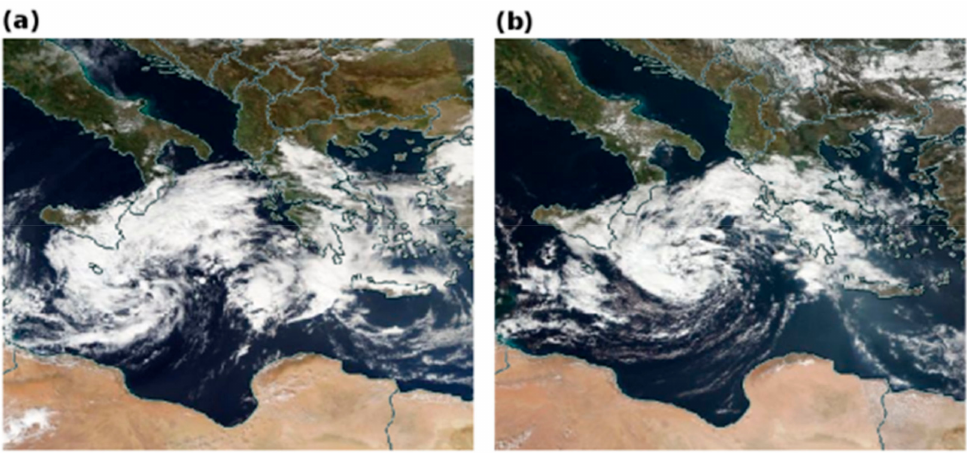
Figure 3. ( a ) Moderate Resolution Imaging Spectroradiometer (MODIS) / Aqua reflectance for 29 October 2016 and ( b ) Visible Infrared Imaging Radiometer Suite / National Polar-orbiting Partnership (VIIRS / NPP) Suomi reflectance for 30 October